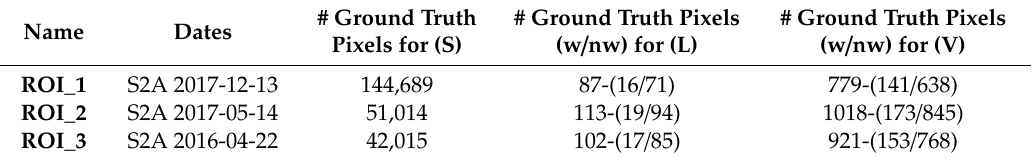
Table 2. Number of pixels (w / nw stand for water / not water) for ROI sites used for the soft constraints definition (S), ordered weight averaging (OWA) learning (L) and 10-fold cross typical / atypical validations (V).